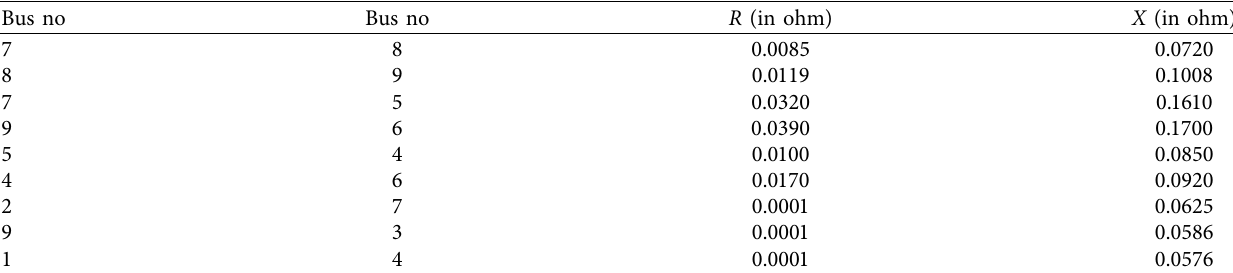
Figure 14: Modifed IEEE 9 bus microgrid test system. Table 3: Line parameters for 9 bus test